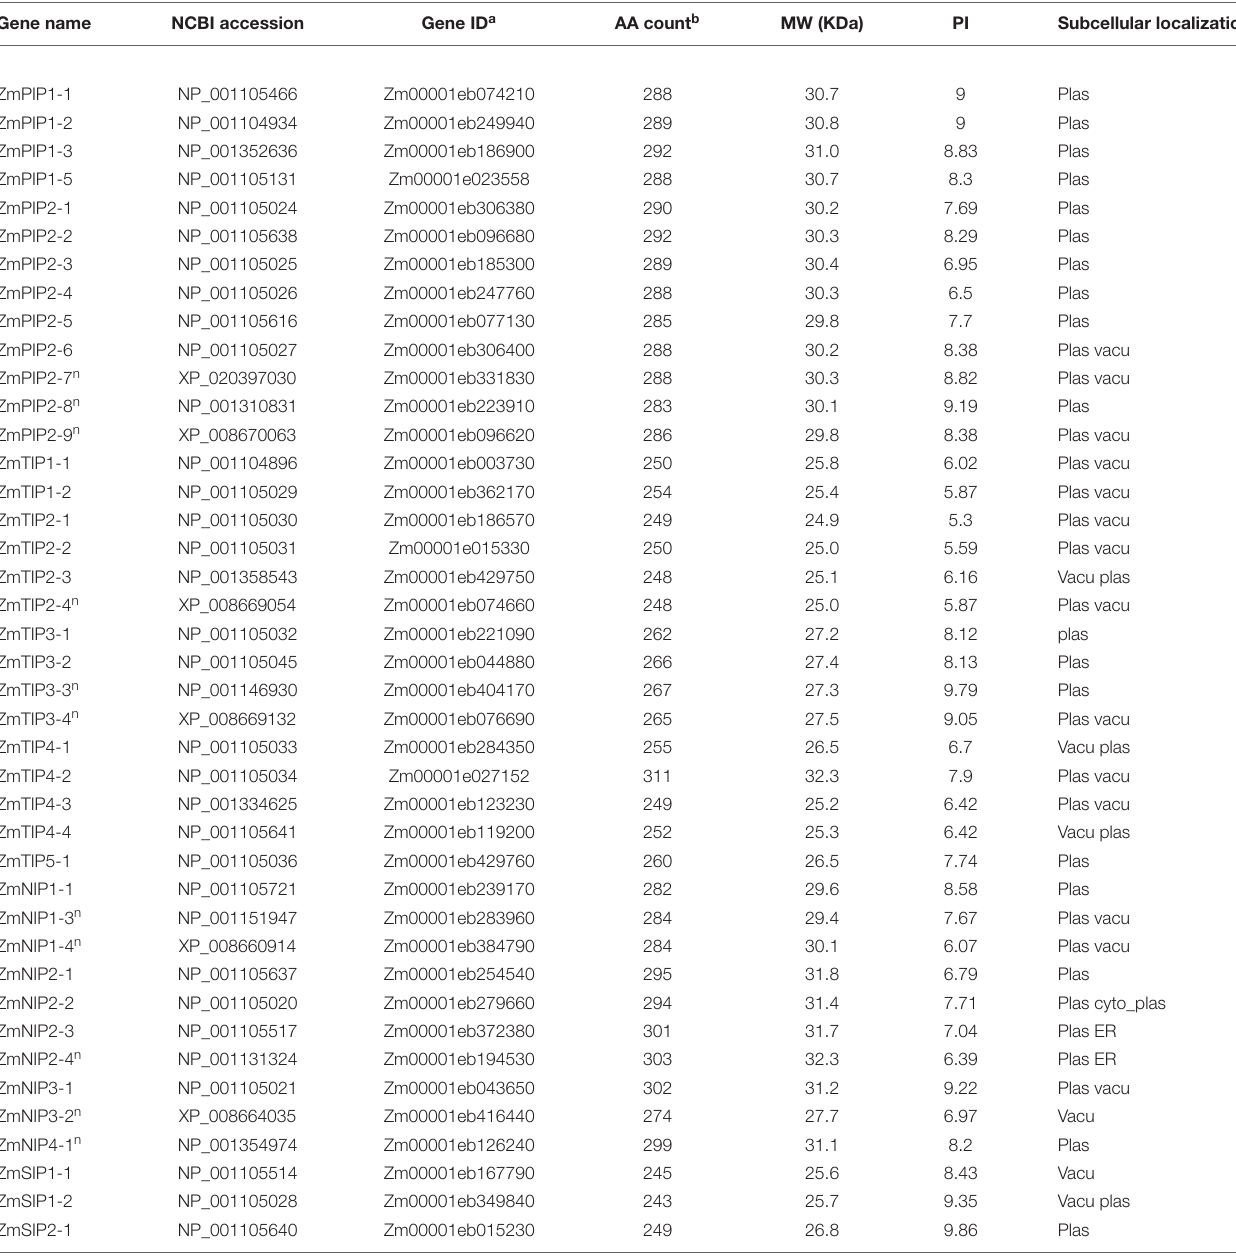
TABLE 1 | Aquaporin genes in the Z. mays